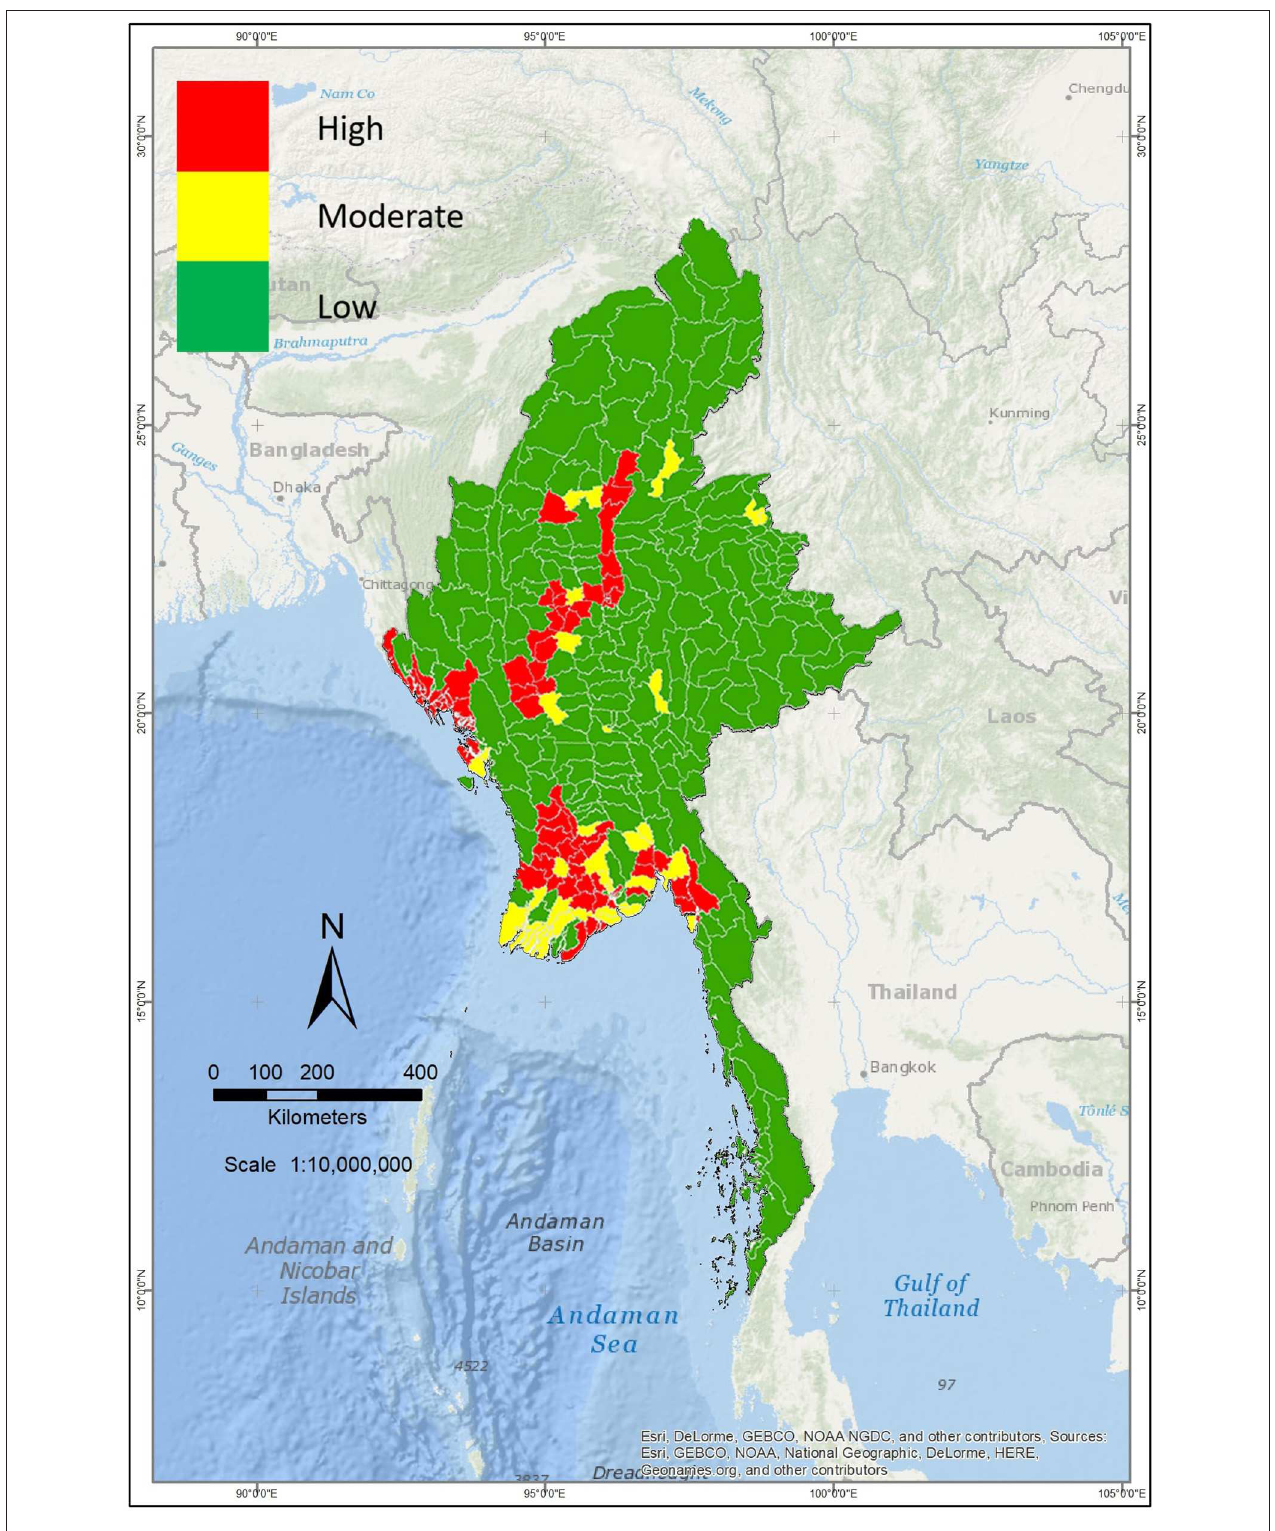
FIGURE 9 | Flood risk index at a township level in